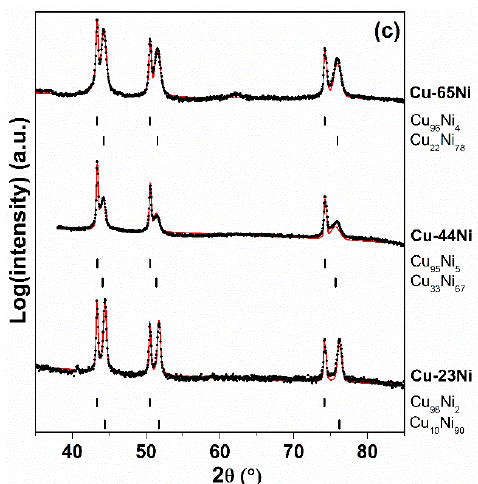
Figure 2. X-ray diffraction (XRD) patterns of partially oxidized wires ( a ); oxide microtubes obtained after chemical etching of the partially oxidized wires ( b ); metallic microtubes obtained after reduction of the oxide microtubes ( c ) for Cu-65Ni, Cu-44Ni, Cu-23Ni and Cu samples. Black dots and red lines represent experimental points and refined patterns, respectively. Vertical lines at the bottom of each figure indicate the positions of the crystallographic reflections for the different phases. Table 2. Quantitative phase analysis (wt. %) and corresponding lattice parameters of Cu-65Ni, Cu-44Ni, Cu-23Ni and Cu samples after oxidation, chemical etching and reduction, obtained by Rietveld refinement of the X-ray diffraction (XRD) patterns shown in Figure 2.